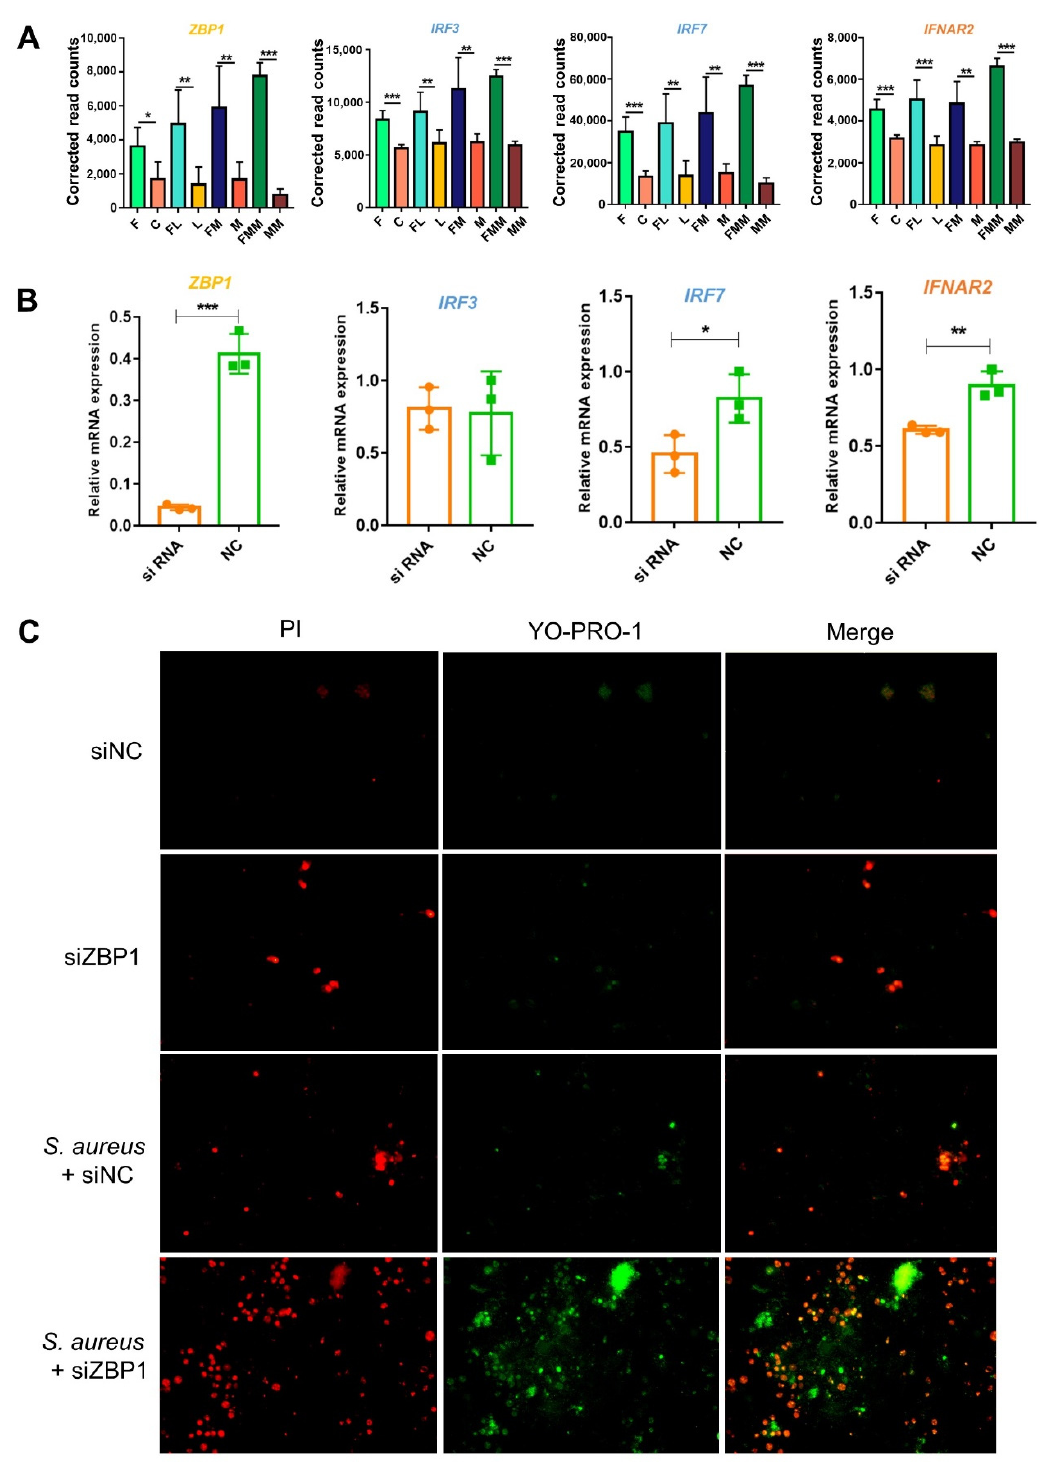
Figure 5. ZBP1 can be regarded as a potential target of reducing the damage induced by S. aureus and MRSA in Mac-T. ( A ) In the FA treatment groups, the expression of ZBP1 , IRF3, IRF7, and IFNAR2 within the cytosolic DNA-sensing pathway is activated. (* p < 0.05, ** p < 0.01 and *** p < 0.001) ( B ) Relative mRNA expression of downstream genes of ZBP1 after ZBP1 knockdown. ( C ) The knockdown of ZBP1 leads to cell apoptosis and necrosis. The nucleus of apoptotic cells were strained green by YO-PRO-1; The nucleus of necrotic cells were strained green and red by YO-PRO-1 and PI; the nucleus of normal cells cannot be stained any color. siNC: negative control.